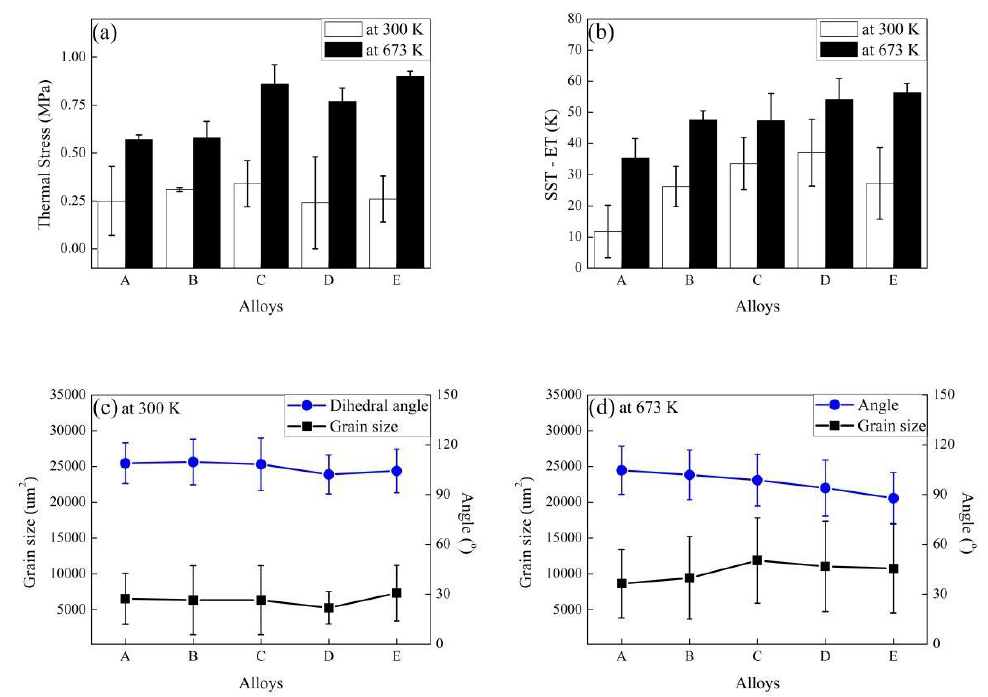
Figure 5. Summaries of ( a ) thermal stresses, ( b ) the difference between SSTs and eutectic temperatures (ETs), and ( c , d ) grain sizes and dihedral angles of the five different alloys prepared in the mold without heating and with heating to 673 K, respectively.